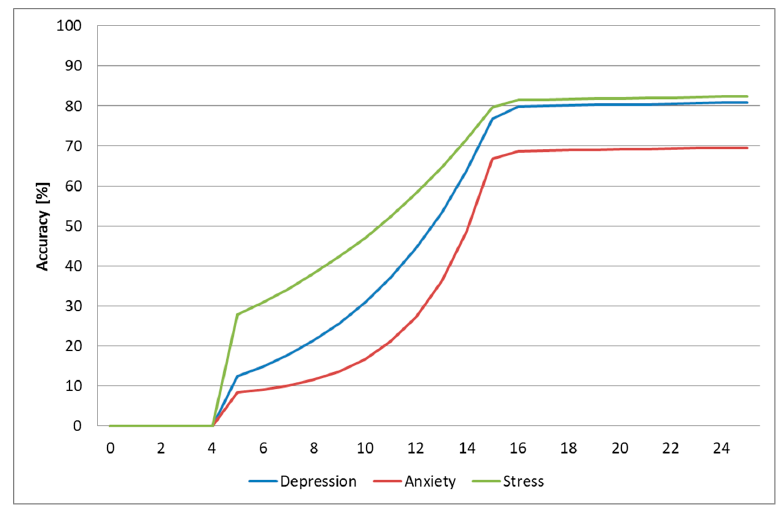
Figure 14. Prediction accuracy based on the number of seconds analyzed from the test video samples (intersubject